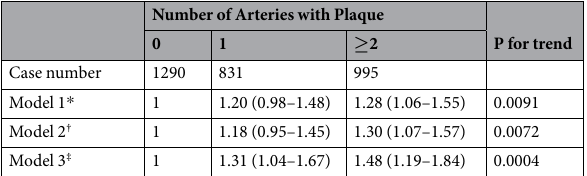
Table 3. Odds ratios of cognitive impairment by number of carotid arteries with plaque. * Adjusted for age, sex. † Adjusted for as model 1 plus education level, marriage status, alcohol use, tobacco use, physical activity, hypertension, diabetes, hypercholesterolemia, atrial fibrillation and coronary artery disease. ‡ Adjusted for as model 2 plus NIHSS and TOAST. NIHSS: National Institutes of Health Stroke Scale; TOAST: Trial of Org 10172 in Acute Stroke Treatment.